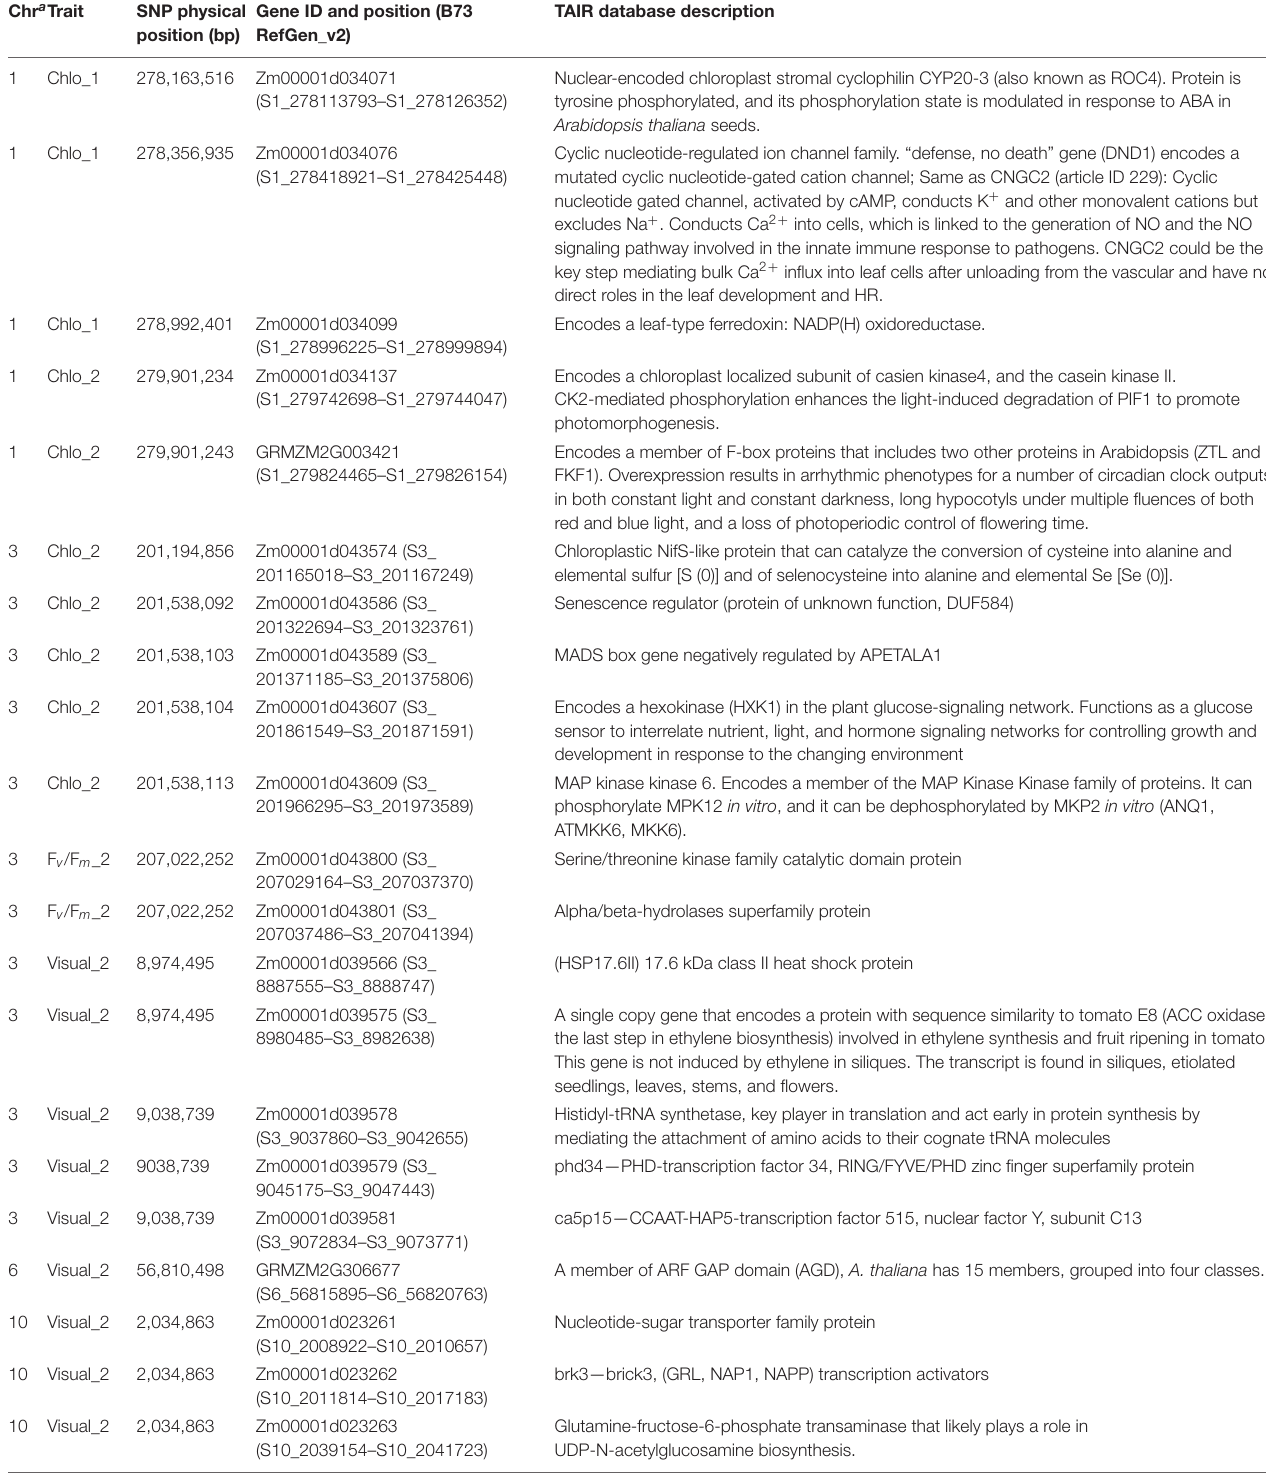
TABLE 4 | Candidate genes and physical positions for each significant SNP associated with Chlo_1, Chlo_2, and F v /F m _2, visual senescence, and their respective descriptions. Chr a Trait SNP physical Gene ID and position (B73 position (bp)